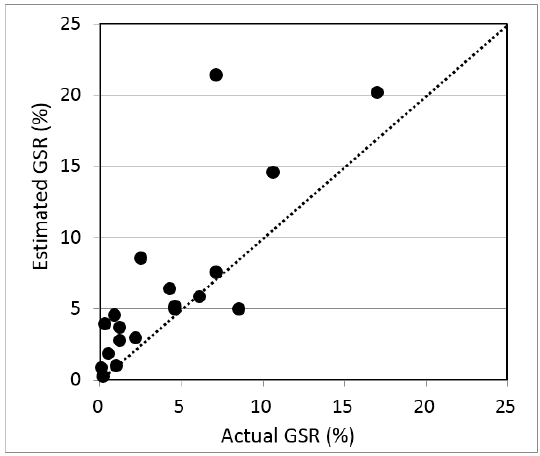
Figure 13. Comparison of actual GSR and estimated GSR.